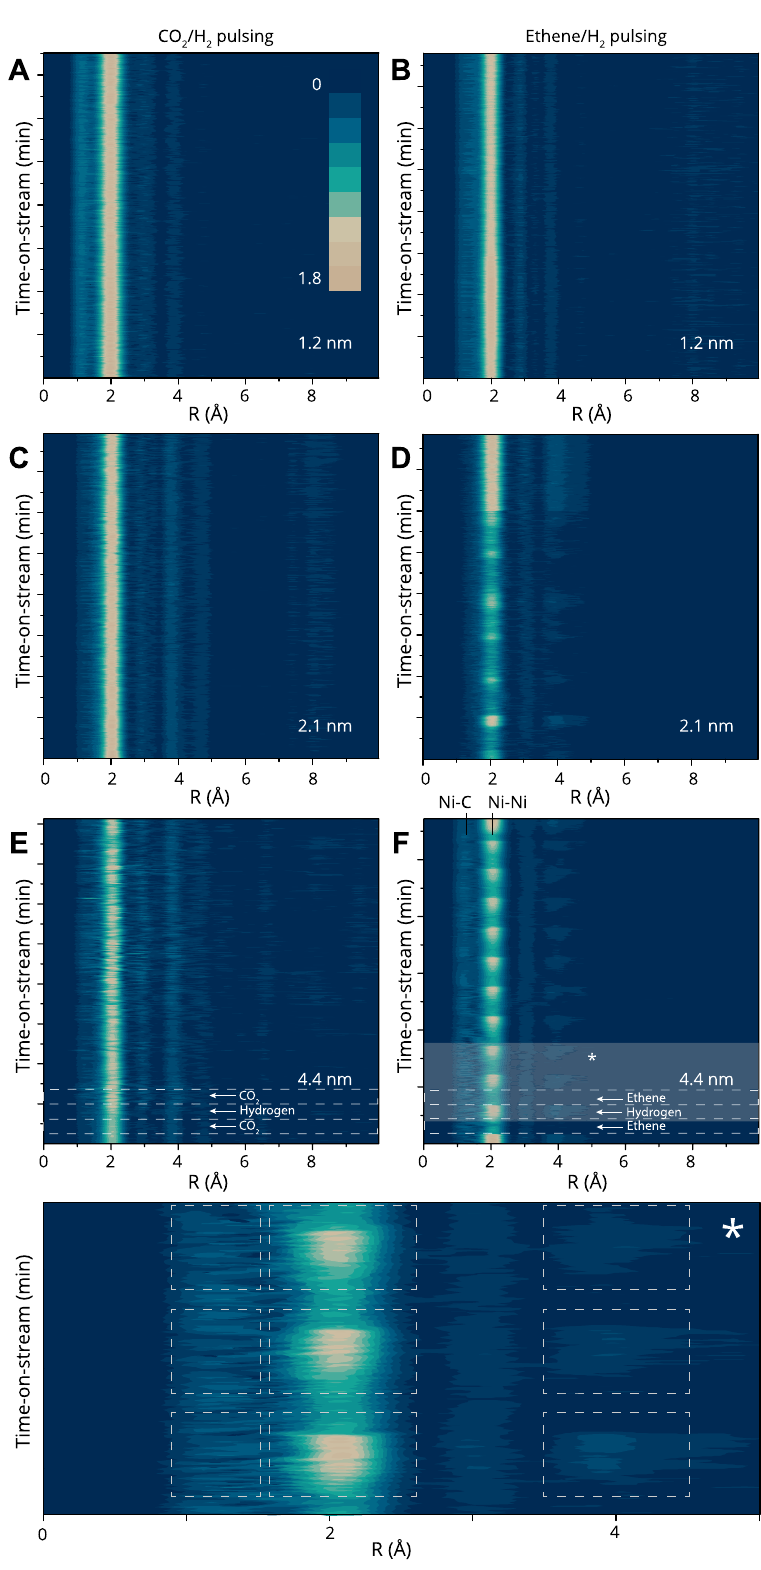
Fig. 2 Operando time-resolved quick-EXAFS during feedstock pulses shows particle-size-dependent restructuring. Top view of the Fourier transform of the quick-XAS spectra at 2 s time resolution of feedstock pulsed experiments for 3 catalyst samples with different mean Ni particle sizes. See also relevant EXAFS in the Supporting information, Supplementary Figs. 15 and 28. a , c , e pulsing CO 2 and H 2 at 400 °C and b , d , f pulsing ethene and H 2 at 150 °C and ambient pressure. See Supplementary Fig. 29 for the average EXAFS of each experiment shown in a – f .